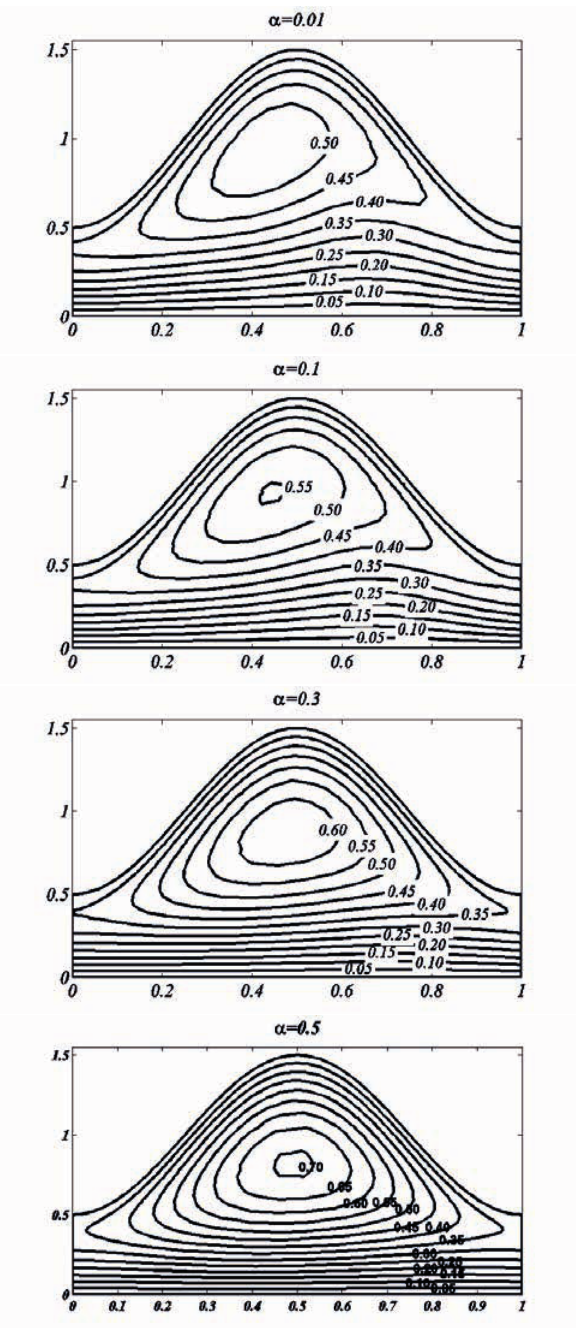
Fig. 12: Variation of vorticity for different values of β with Re = 10.0, M = 2, α = 0.2, φ = 0.5, Q = 1.3 .